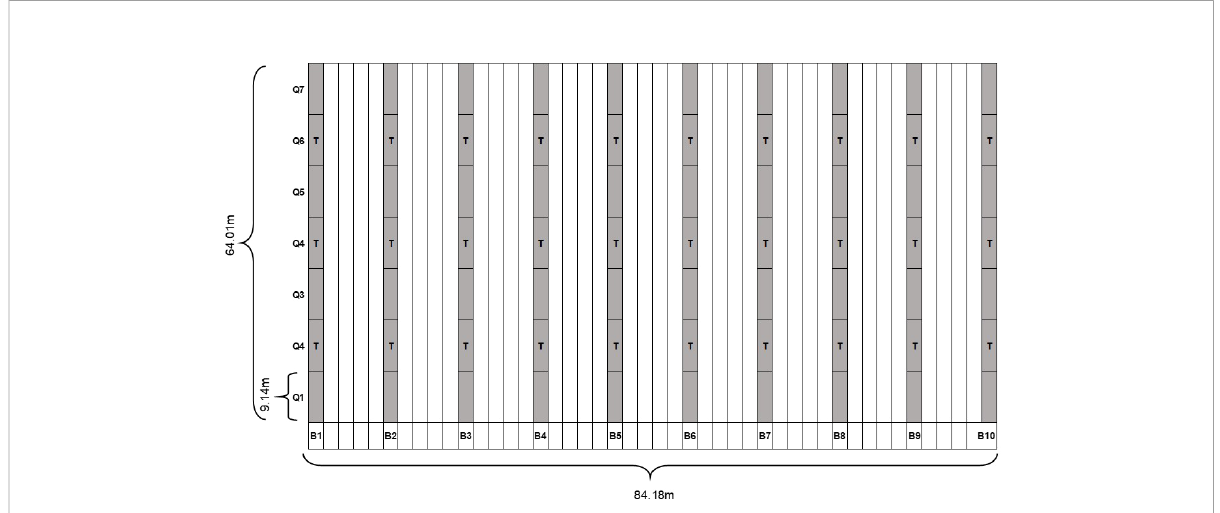
FIGURE 2 Study design for survey of commercial squash fi elds. Each gray cell represents a 1.83m x 9.14m quadrat. White columns represent 4 rows between each sampling row (gray columns); WTVC incidence was taken per quadrat. Q= quadrats; B = beds; T= indicates where traps were